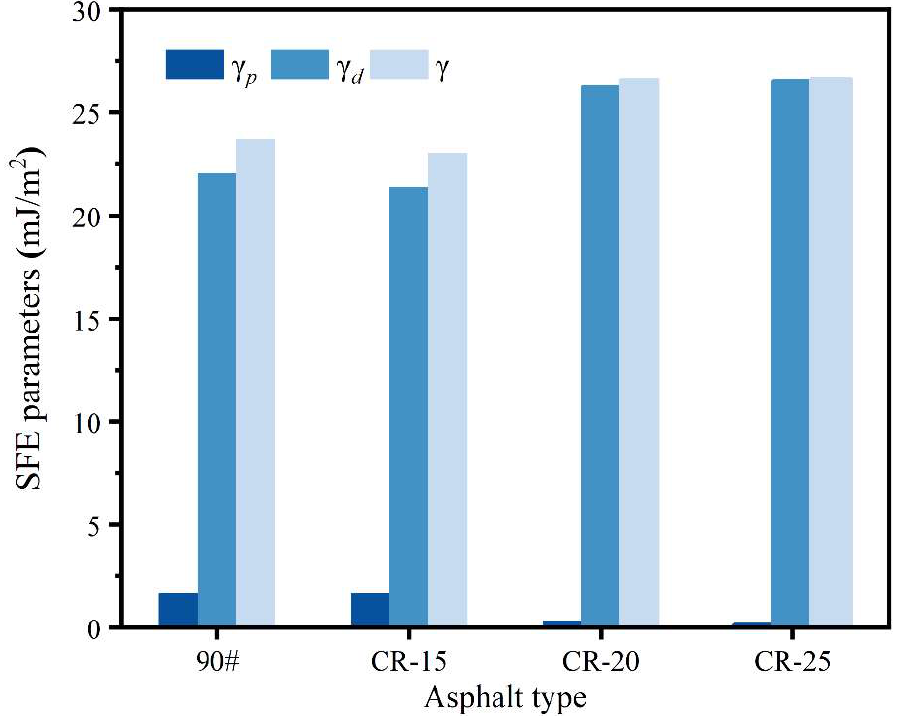
Figure 7. SFE parameters of different rubberized asphalts.